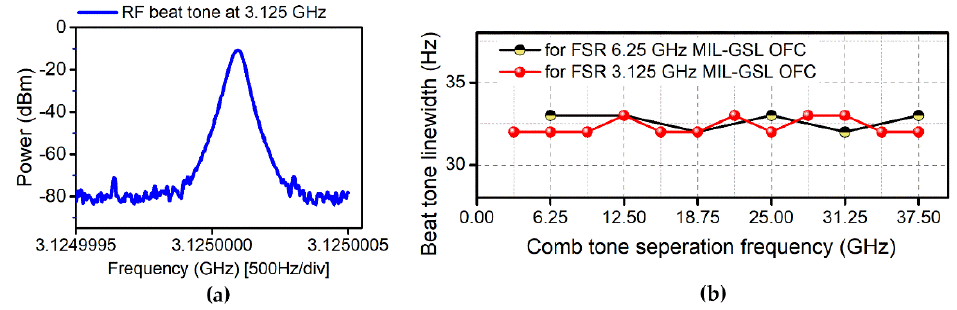
Figure 8. ( a ) An electrical spectrum of the resultant beat tone at 3.125 GHz; ( b ) RF beat tone linewidth